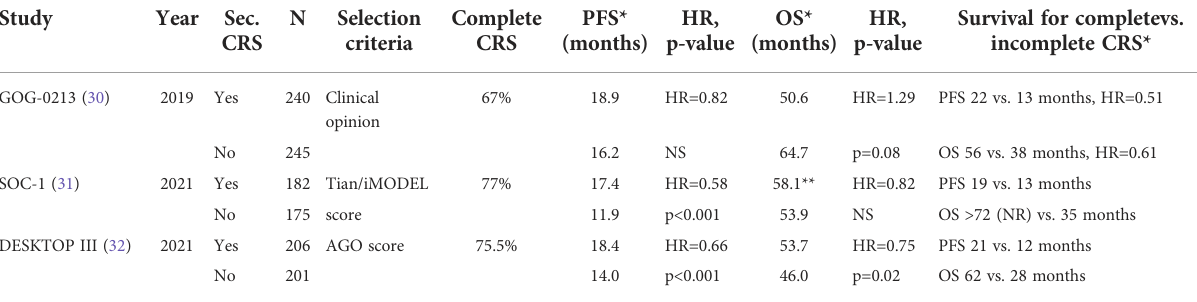
TABLE 1 Results of randomized controlled trials on secondary cytoreductive surgery for recurrent ovarian cancer.